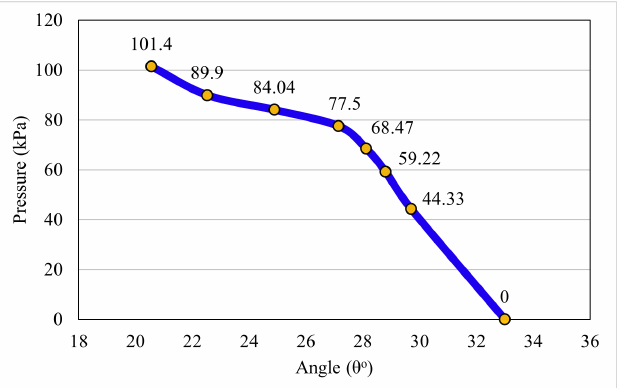
Figure 12. The relationship between air pressure (kPa) and angular deviation ( θ